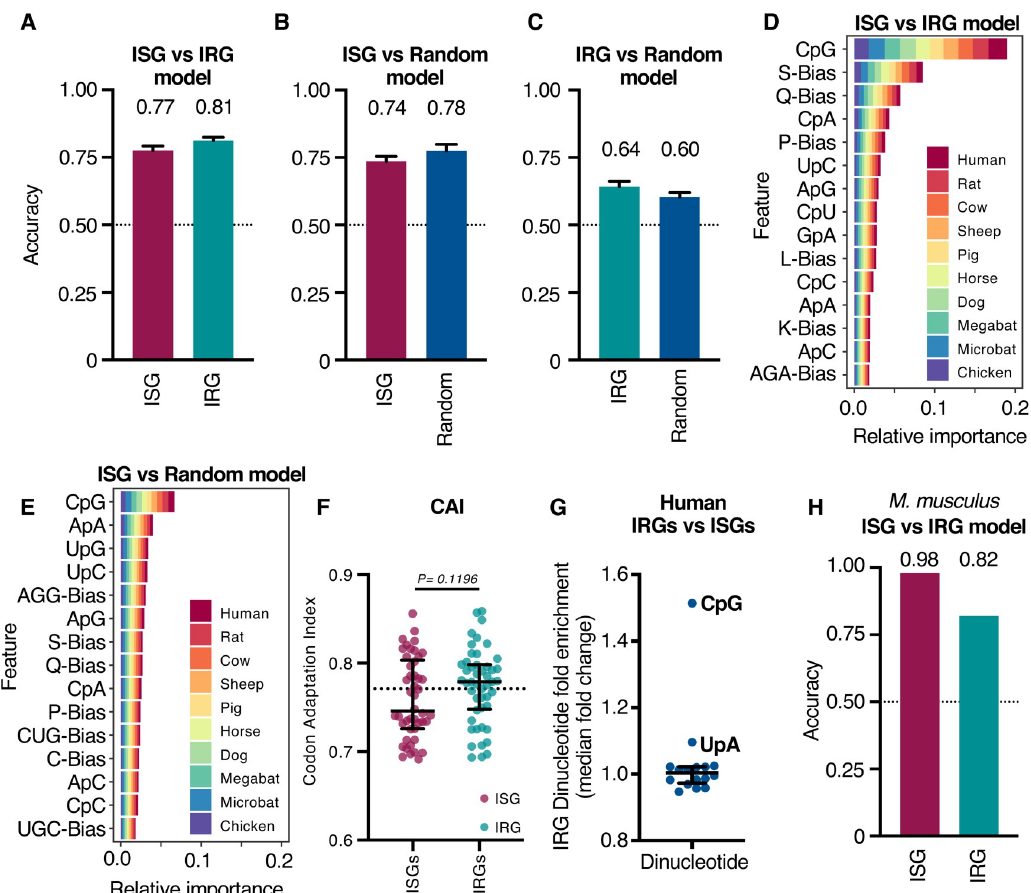
Fig 1. Compositional features predict expression class following IFN treatment. (A–C) Accuracy of classifiers trained to distinguish the top 50 most DE ISGs from the top 50 most DE IRGs (A), ISGs from 50 random genes (from each species) (B), or IRGs from 50 random genes (from each species) (C). Bars show the average proportion of genes in each class that were accurately identified across 50 replicates of 5-fold cross-validation, while error bars show the region containing 95% of observed accuracy values. Dashed lines indicate the expected performance of a null (i.e., uninformative) model. (D, E) The 15 most important features used by classifiers to distinguish ISGs from IRGs (D) or ISGs from random genes (E). The equivalent panel with the features used by classifiers to distinguish IRGs from random genes is shown in S3 Fig. Feature importance was quantified for individual genes using the SHAP approach [23,24],before summing their magnitude across all genes from a given species. All classifiers were trained and evaluated on 500 genes from each class, representing the top 50 ISGs or IRGs, or 50 random genes, from each species. Three-letter codes of the form “CpG” indicate measures of dinucleotide composition, single letters followed by the word “bias” (e.g., S-Bias) indicate amino acid composition biases, and 3 letters followed by the word “bias” (e.g., AGA-Bias) indicate codon usage biases. (F) The CAI of the 50 most DE ISGs and IRGs calculated as described previously [25]. The CAI is a measure of optimal codon usage; a higher CAI indicates a more optimal usage of codons. The horizontal dotted line represents the median for all transcripts in the human genome. Statistical significance was assessed using the Wilcoxon rank sum test with continuity correction. (G) The fold change in median dinucleotide composition between the top 50 most DE ISGs and IRGs in humans (summarising S2 Fig). The underlying RNA-seq data analysed in (A–G) were our previously published open-access data [4]. Briefly, primary fibroblasts derived from human, rat, cow, sheep, pig, horse, dog, little brown bat, and chicken, as well as immortalised large flying fox cells, were treated with type I IFNs (1,000 U/ml universal IFN, 200 ng/ml canine IFN α , 1,000 U/ml porcine IFN α , or 200 ng/ml chicken IFN α ) for 4 hours before being analysed using RNA-seq [4]. (H) Accuracy of classifiers trained to distinguish the top 50 most DE ISGs from the top 50 most DE IRGs in a microarray dataset from a species not used to develop the model (murine NIH 3T3 cells +/ − 100 units IFN [26], extracted from the interferome database [2]). The underlying data from this figure are openly available (http://dx.doi.org/10.5525/gla.researchdata.1159). CAI, Codon Adaptation Index; DE, differentially expressed; IFN, interferon; IRG, interferon-repressed gene; ISG, interferon-stimulated gene; RNA-seq, RNA sequencing; SHAP, SHapley Additive